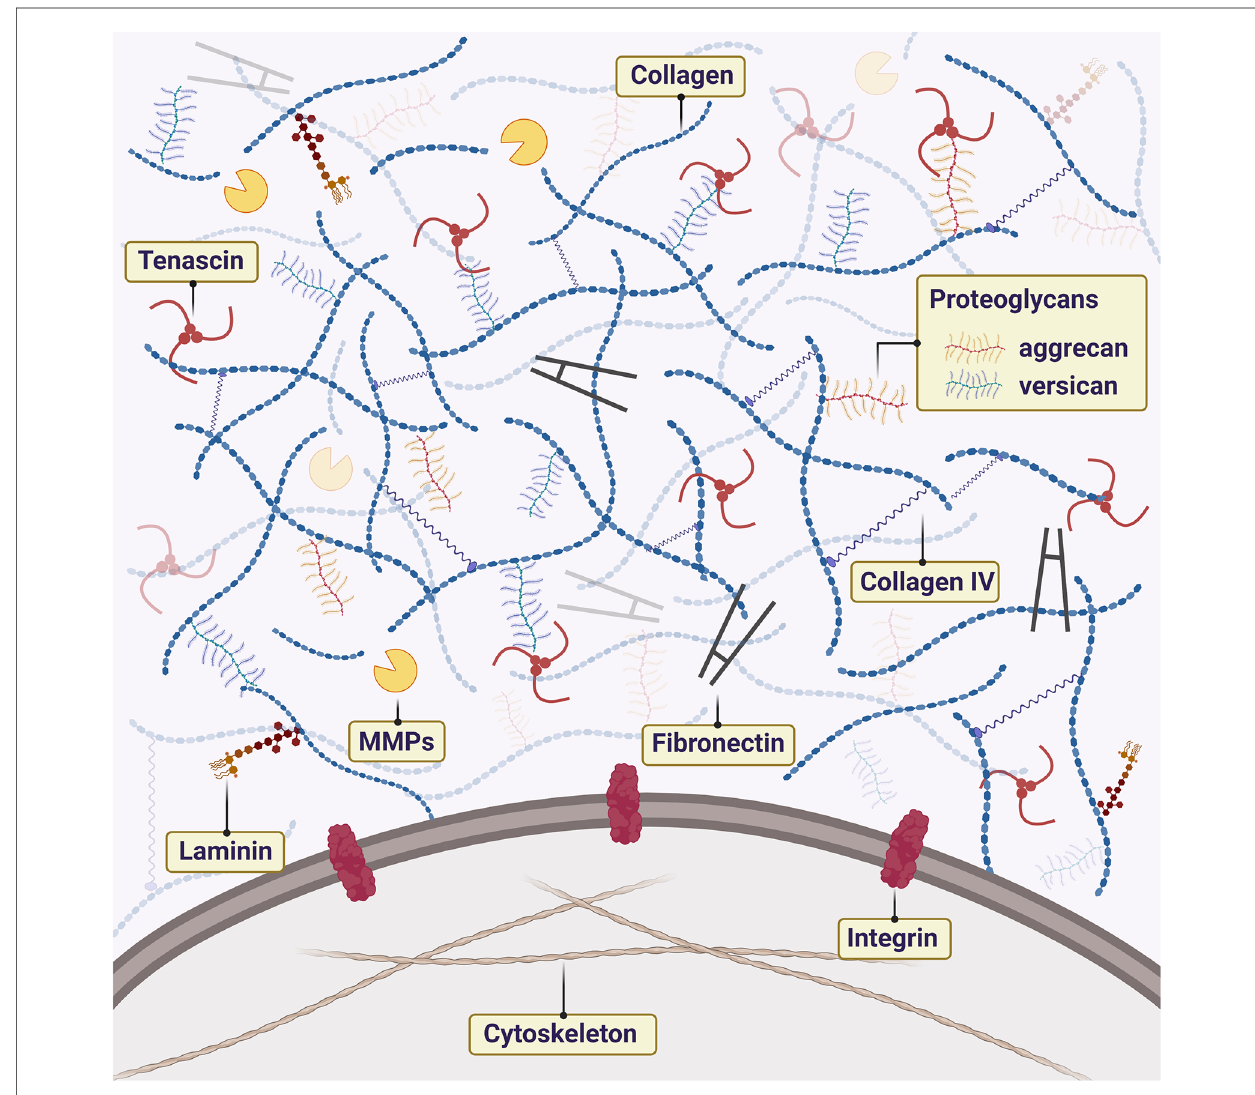
FIGURE 1 Schematic illustration of extracellular matrix (ECM) components in the tumor microenvironment of PA and CXPA. ECM is rich in macromolecules such as laminins, proteoglycan (PG) complex, collagen, and fi bronectin. The interaction between cells and ECM is mainly mediated by cell receptors of the matrix components, such as integrins. Metalloproteinases (MMPs) promote the degradation and remodeling of ECM, favoring cell